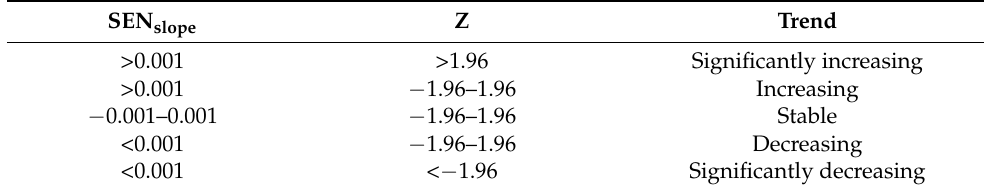
Table 2. Water retention change trend assessment table. SEN slope Z Trend >0.001 >1.96 Significantly increasing >0.001 − 1.96–1.96 Increasing − 0.001–0.001 − 1.96–1.96 Stable <0.001 − 1.96–1.96 Decreasing <0.001 < − 1.96 Significantly